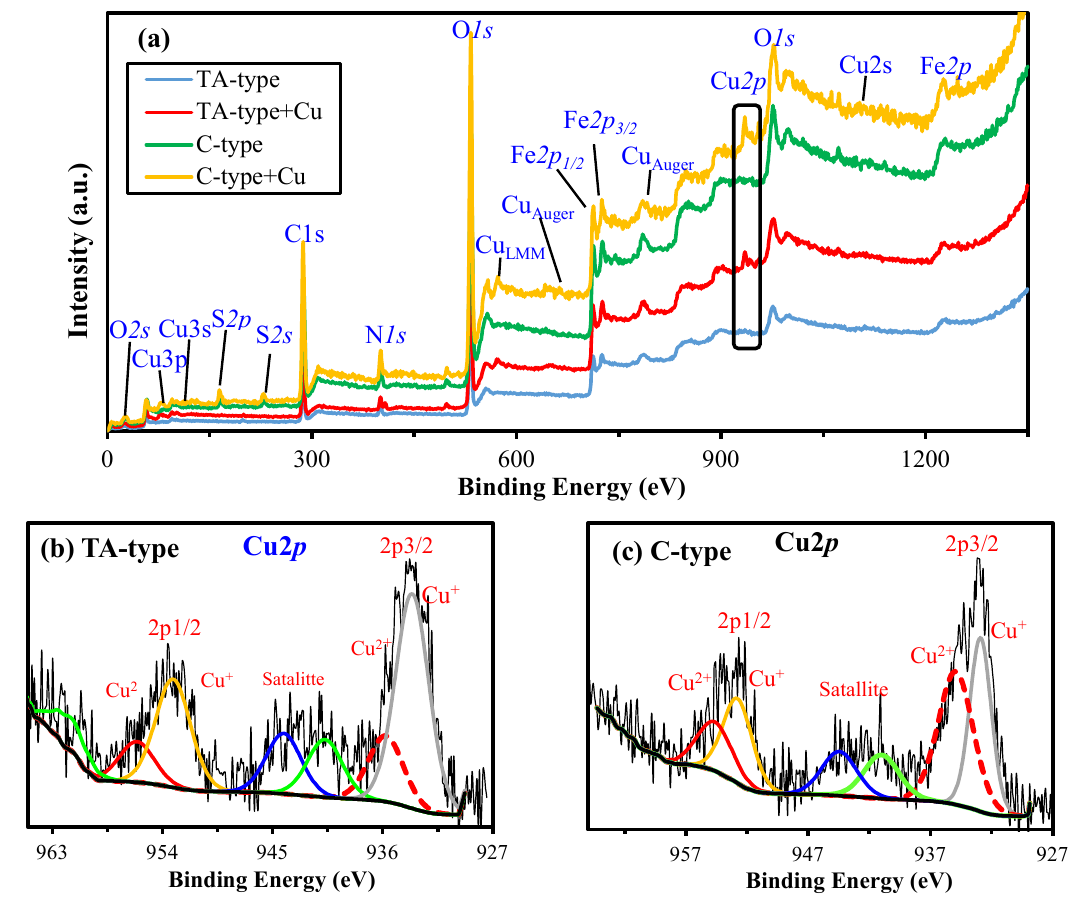
Figure 7. XPS survey spectra of raw TA-type and C-type adsorbent before and after Cu(II) adsorption ( a ) and core level for Cu2 p ( b , c ).